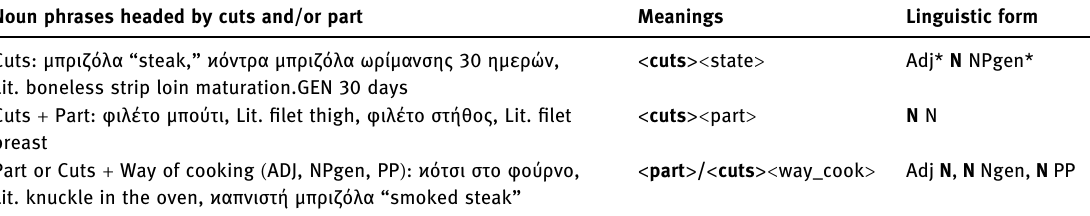
Table 10: The dish name is headed by a noun denoting < cuts > or < part > . No MI is supplied Noun phrases headed by cuts and/or part Meanings